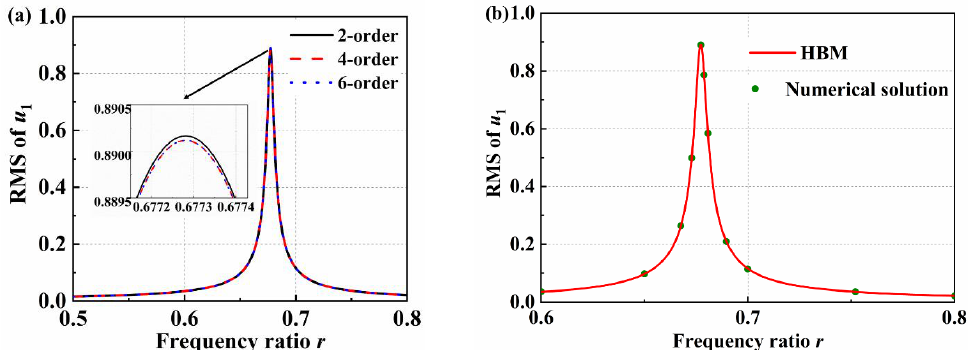
Figure 2. Comparison of the approximate analysis under f e = 0.1 mm: ( a ) with different harmonic orders; ( b ) with the Runge – Kutta. orders; ( b ) with the